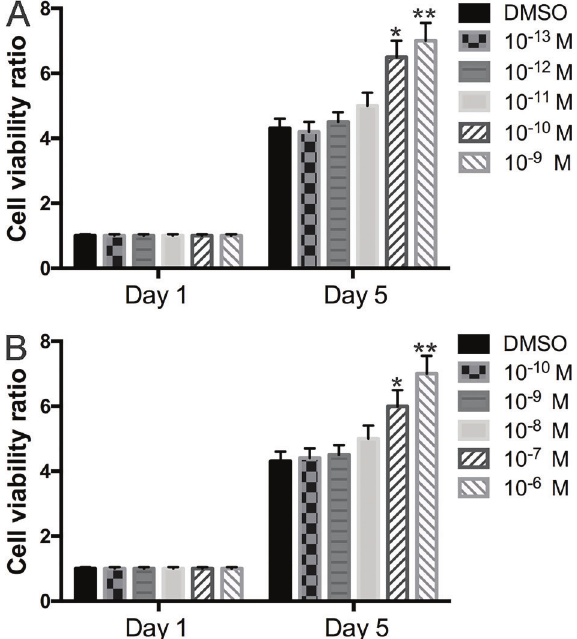
Figure 1. Effect of different concentrations of estradiol ( A ) or progesterone ( B ) alone in MCF-7 cell viability. DMSO was used as control. Data are reported as means ± SD. *P o 0.05; **P o 0.01 vs DMSO group (control) (Student ’ s t